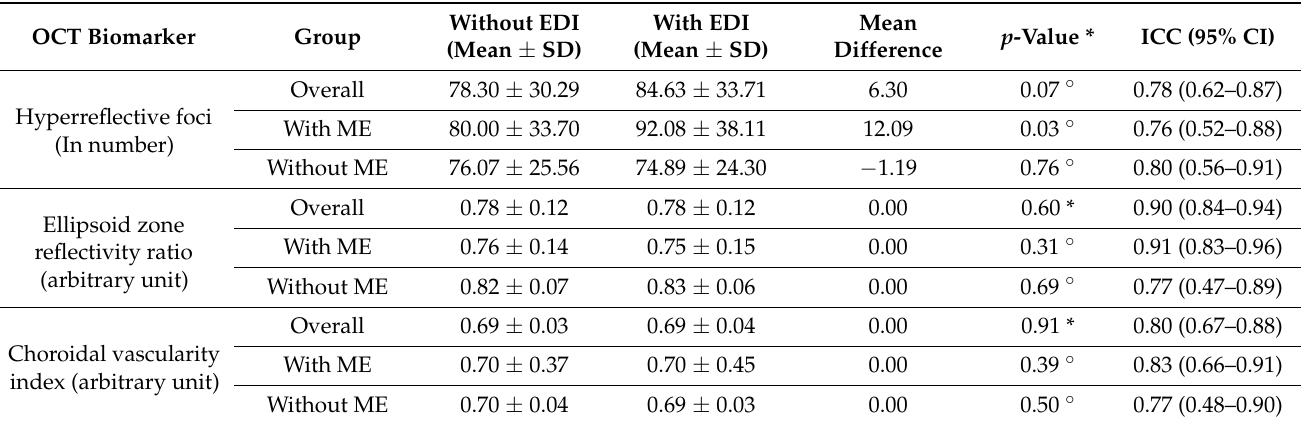
Table 2. Comparison between SD-OCT without and with EDI mode in OCT biomarkers measure- ments.